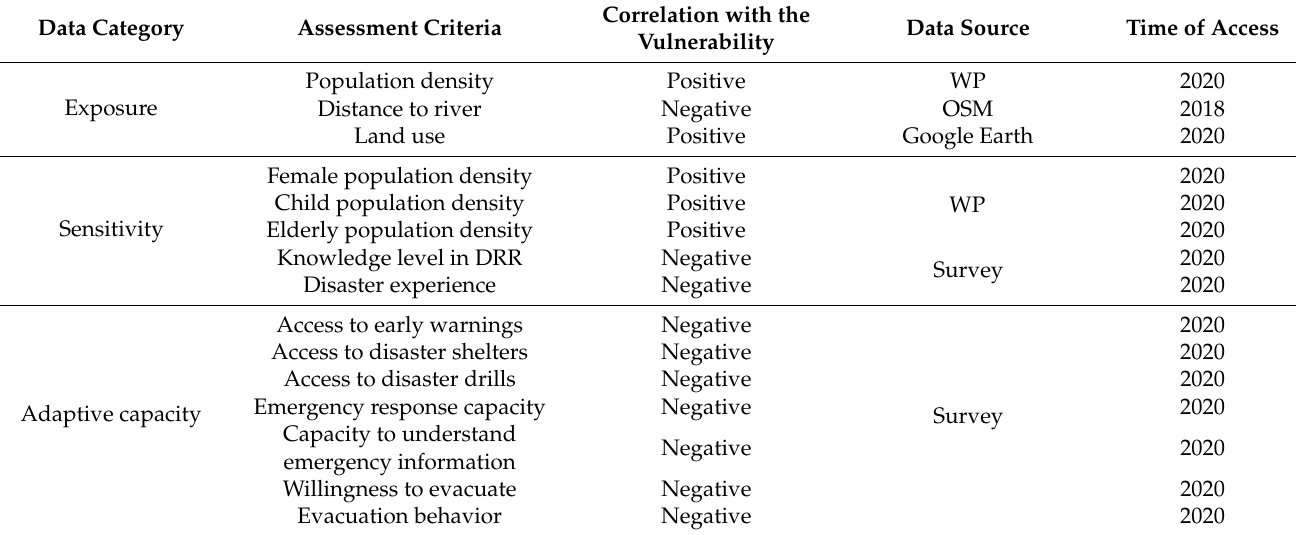
Table 4. Vulnerability data for community